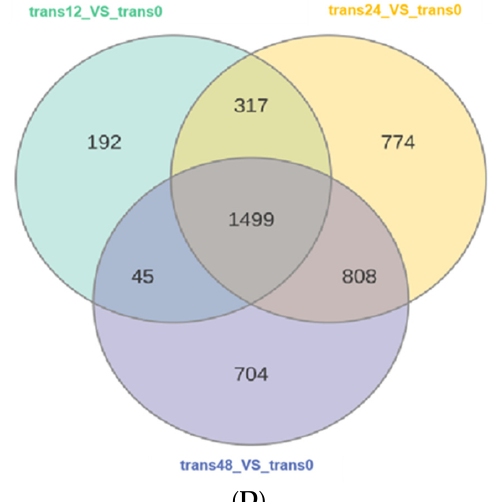
Figure 2. Overall transcriptomic changes in rice in response to SBPH nymph infestation. ( A ) Principal component analysis of each transcriptome sample; the X-axis and Y-axis represent the first and second principal components, respectively. ( B ) Hierarchical cluster analysis of differentially expressed genes (DEGs) between the three groups of SBPH nymphs-infested time-points (trans12, trans24, or trans48) and the uninfested (trans0) group, with each group containing three biological replicates. ( C ) Histogram statistics of DEGs in plants infested by SBPH nymphs (12 h time-point, 24 h time-point, or 48 h time-point) compared to the control group (0 h time-point). Total, all DEGs; own, down-regulated DEGs; p, up-regulated DEGs. ( D ) Venn of DEGs in three comparison groups.